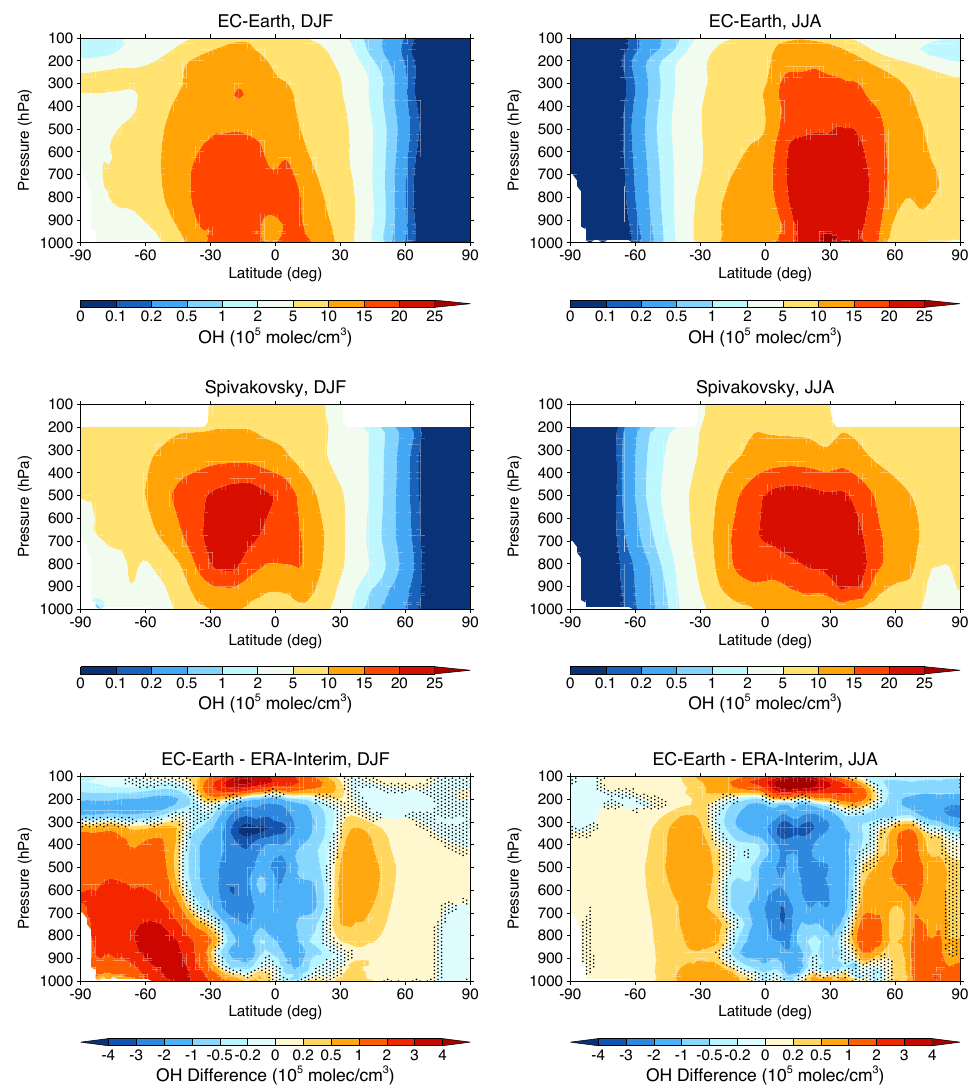
Figure 4. Zonal mean OH concentrations in the reference EC-Earth simulation (top), the climatology of Spivakovsky et al. (2000) reduced by 8% (middle), and the differences between the reference EC-Earth simulation and the corresponding ERA-Interim simulation (bottom) for boreal winter (left) and boreal summer